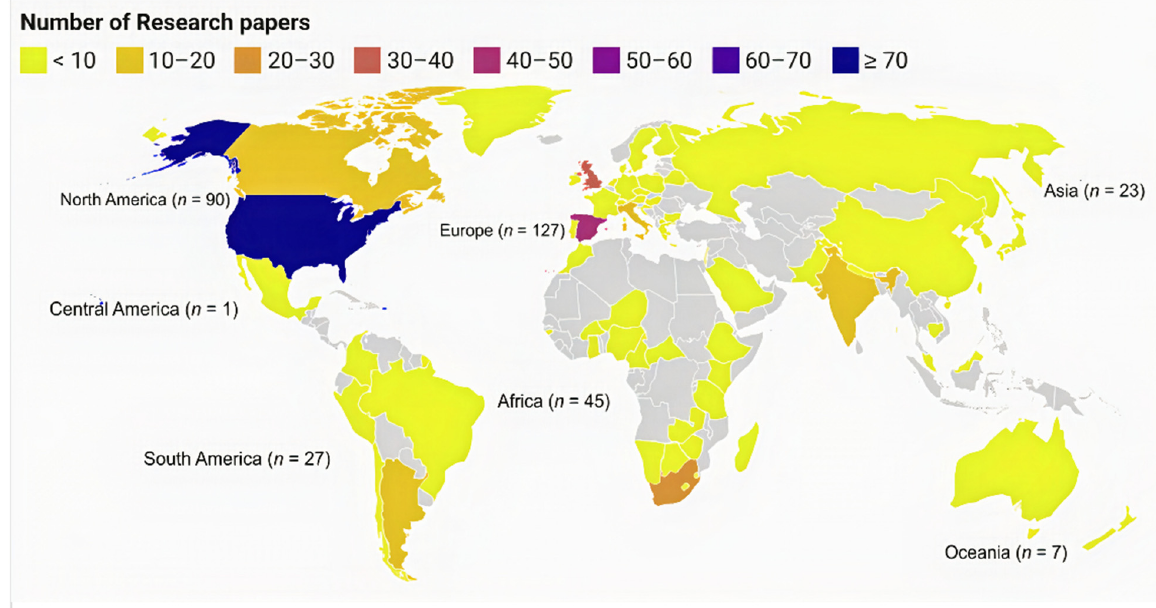
Figure 3. Distribution of the reported study location (country) based on 383 publications identified in a systematic map of human–raptor interaction and coexistence research.